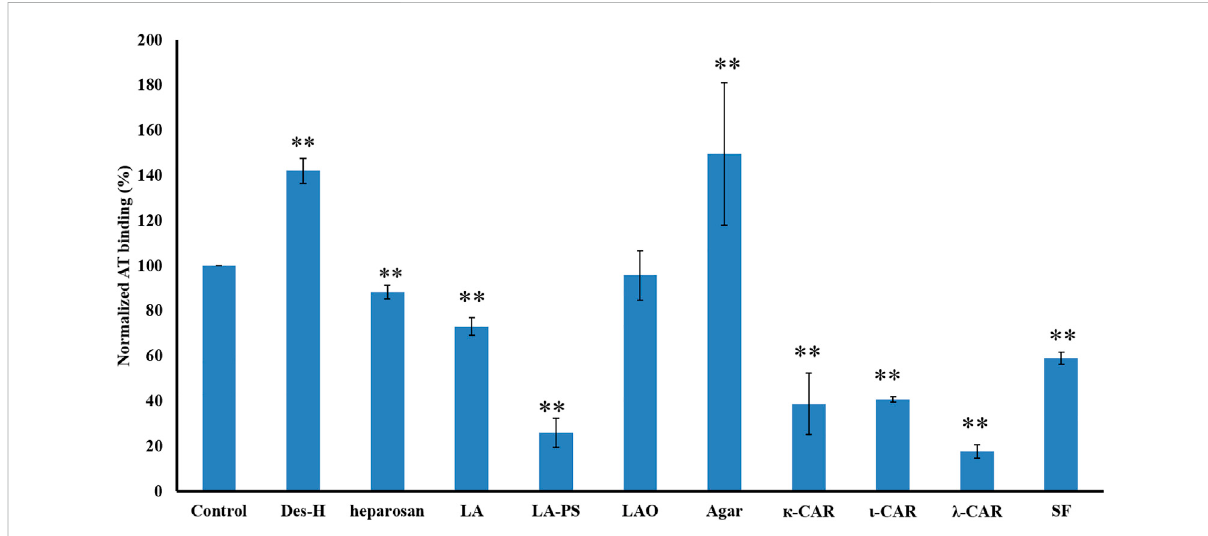
FIGURE 7 The binding abilities to AT of different polysaccharides on a surface heparin chip. Concentrations of AT and sulfated glycan samples were 250 nM and 1 μ M, respectively. All bars with standard deviations were based on triplicate experiments. * p < 0.05, ** p < 0.01 compared with